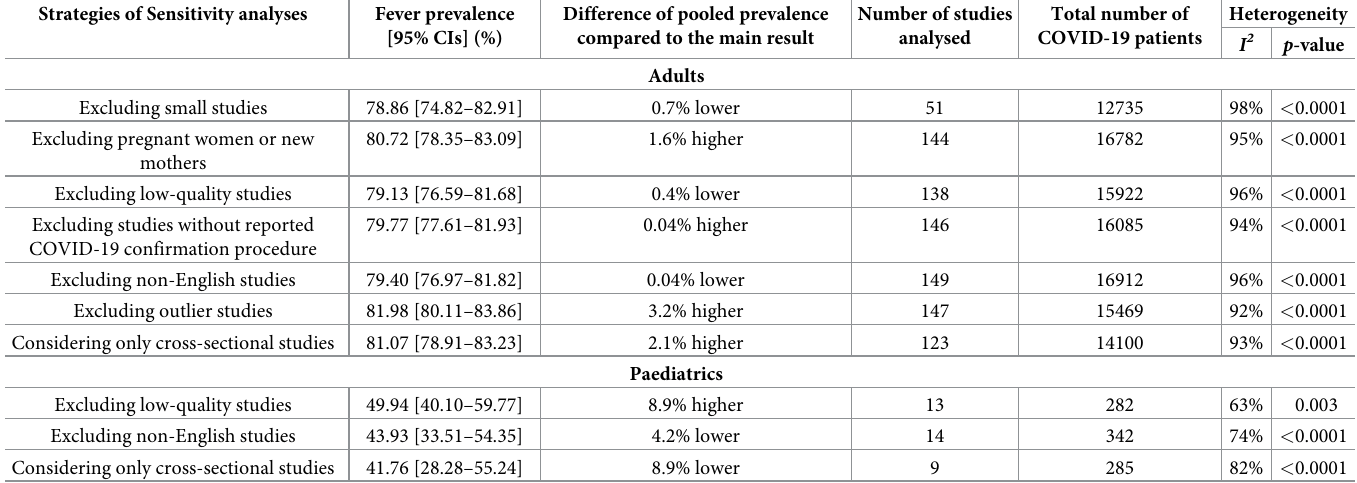
Table 4. Sensitivity analyses.